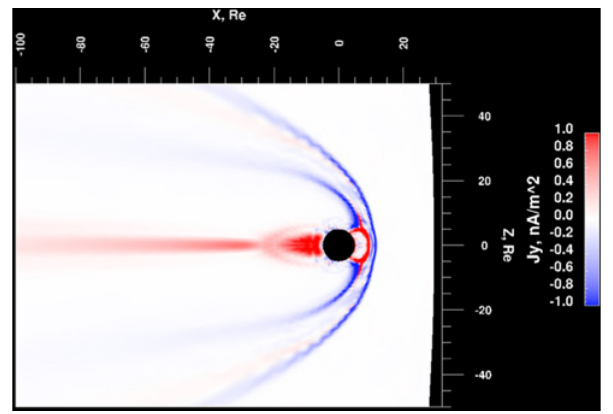
Fig. 2. Distribution of J y in the meridional plane as deter- mined from the LFM magnetosphere simulation under nominal so- lar wind conditions with purely southward IMF ( V = 400kms − 1 , n = 5cm − 3 , B z =−